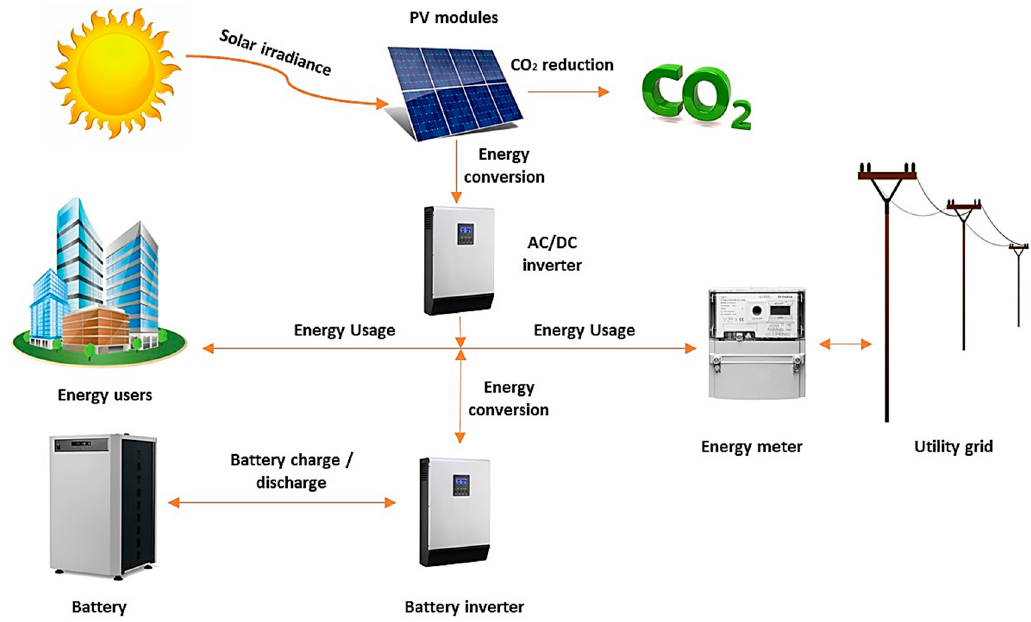
Figure 4. Example of single-phase on-grid system based on SUNNY ISLAND data sheet and technology brochures [41].